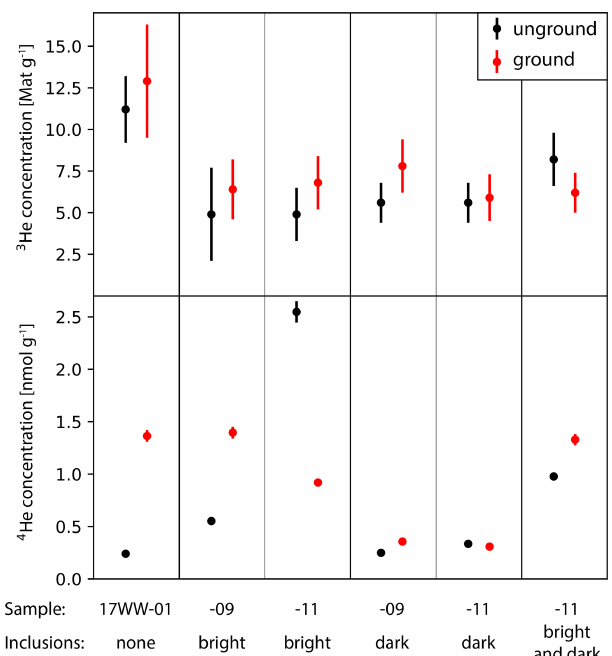
Figure 11. Comparison of aliquots of unground (black) and ground (red) magnetite aliquots with 2 σ uncertainties. The 3 He concentra- tions of unground and ground aliquots are identical within the 95% uncertainty bounds. Sample 17WW-01 was taken at the surface, and 17WW-09 and 17WW-11 were taken at 1 and 1.5m of